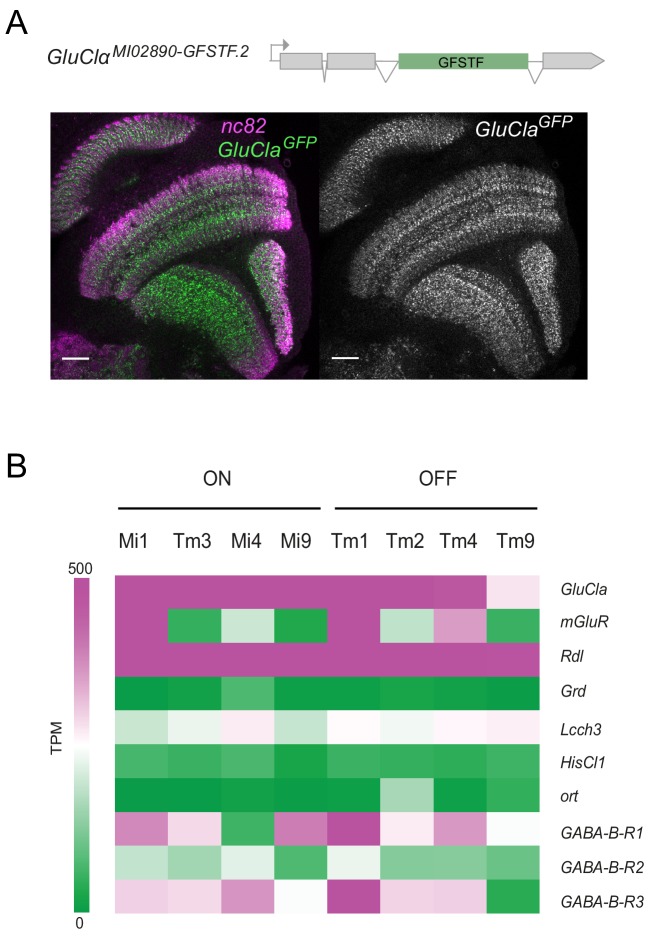
GluClα and Rdl are broadly expressed in the visual system.(A) Confocal cross-section of the visual system of a fly carrying a GFP exon trap within the GluClα locus (GluClαMI02890.GFSTF.2). The neuropil is marked with nc82 (magenta) and endogenous GFP is in green/gray. Scale bar is 20 µm. (B) Expression levels shown as TPM (transcripts per kilobase million) values of inhibitory glutamate, GABA and histamine receptors. RNAseq data are from Davis et al. (2018) (GEO accession number: GSE 116969). Expression in the four most prominent medulla interneurons of the ON and OFF pathways are depicted.